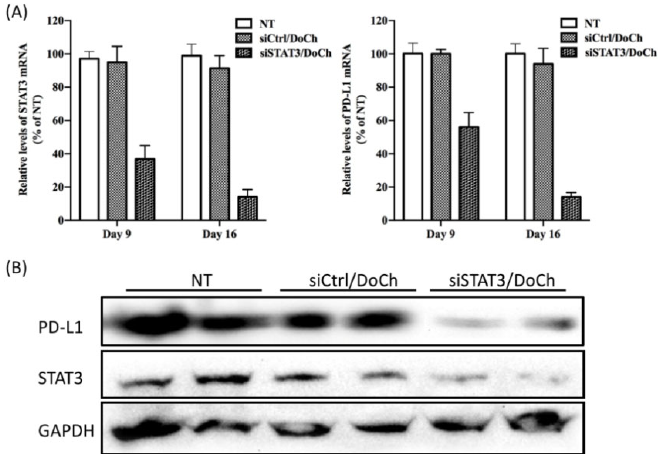
Figure 7. Measurement of the efficiency of DoCh mediated tumor ‐ targeted RNAi delivery. ( A ) RT ‐ qPCR analysis of STAT3 and PD ‐ L1 expression in the tumor tissue after i.v. administration of siSTAT3/DoCh LNP. Values represent the mean ±SEM of tissue samples from 3 tumor regions (4 animals). Data are expressed as percent of control. ( B ) STAT3 and PD ‐ L1 protein levels are reduced in tumor of mice injected with siSTAT3/DoCh LNP. STAT3 and PD ‐ L1 protein expression levels were measured by Western blot 16 days after the injection of 2 mg/kg body weight of siSTAT3 or its control complexed to DoCh, respectively.